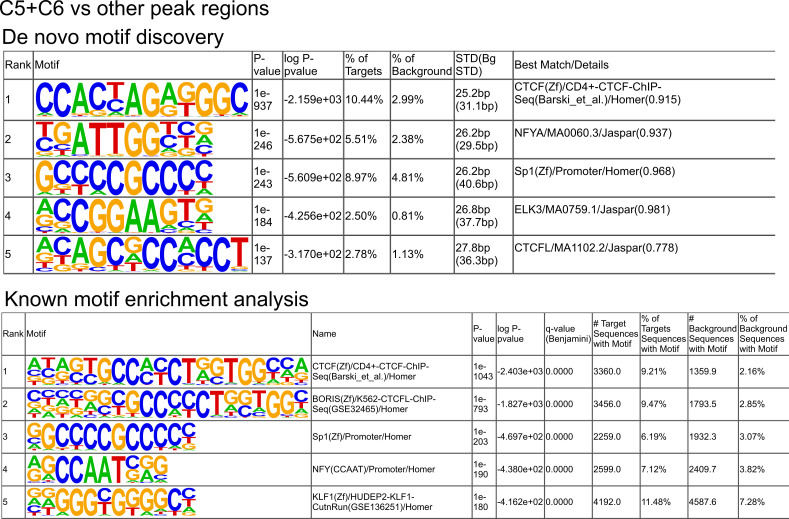
De novo motif discoveries and known motif enrichment analysis of ATAC-seq peaks with an alternative background.The top five motifs from clusters C5 and C6 determined while using all other peaks as the background sequence.